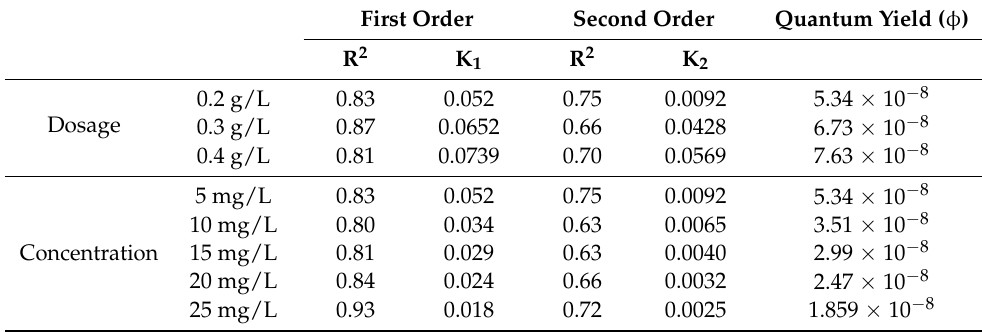
Table 2. The estimated correlation coefficient, kinetic rate constants, and quantum yield